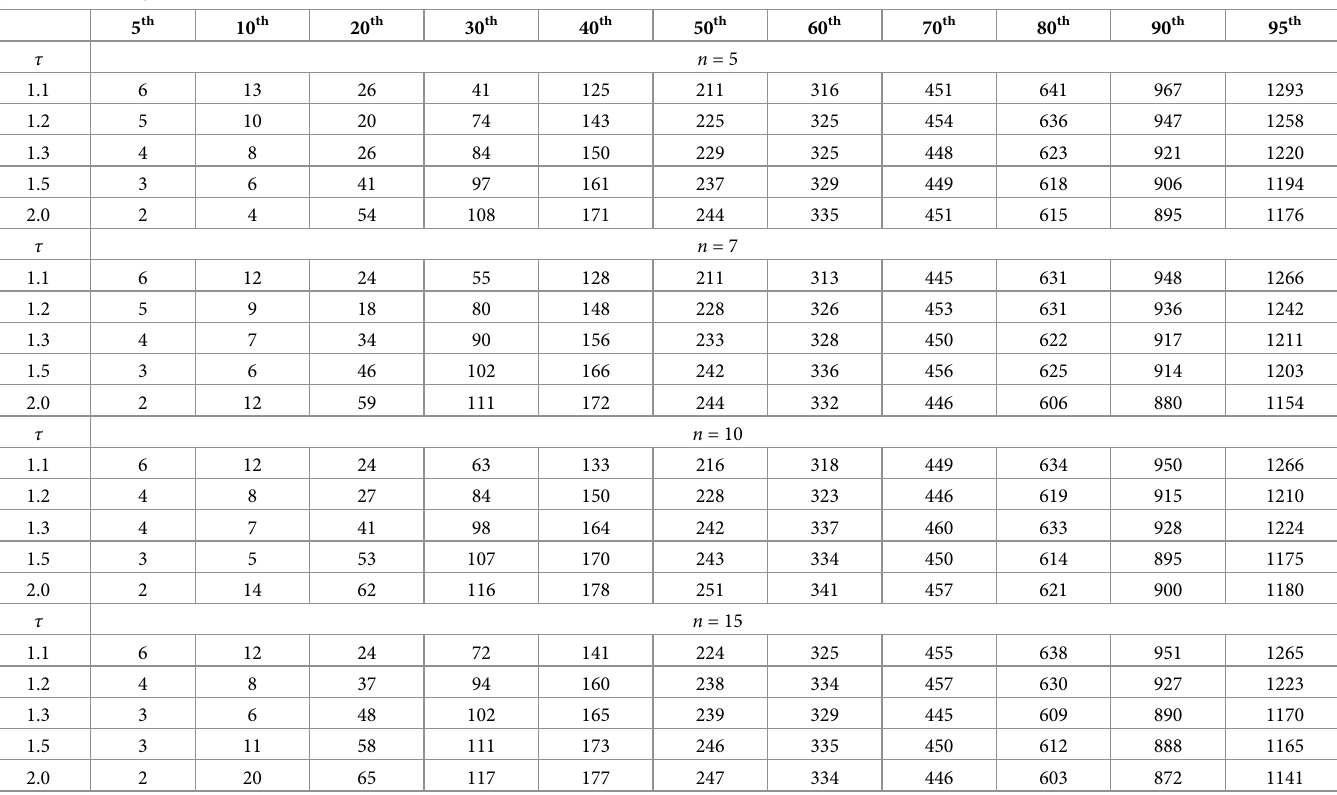
Table 2. In-control percentiles of the run length distribution for the ARL -based side sensitive synthetic- γ chart for γ 0 = 0.05, n 2 {5,7,10,15} and τ 2